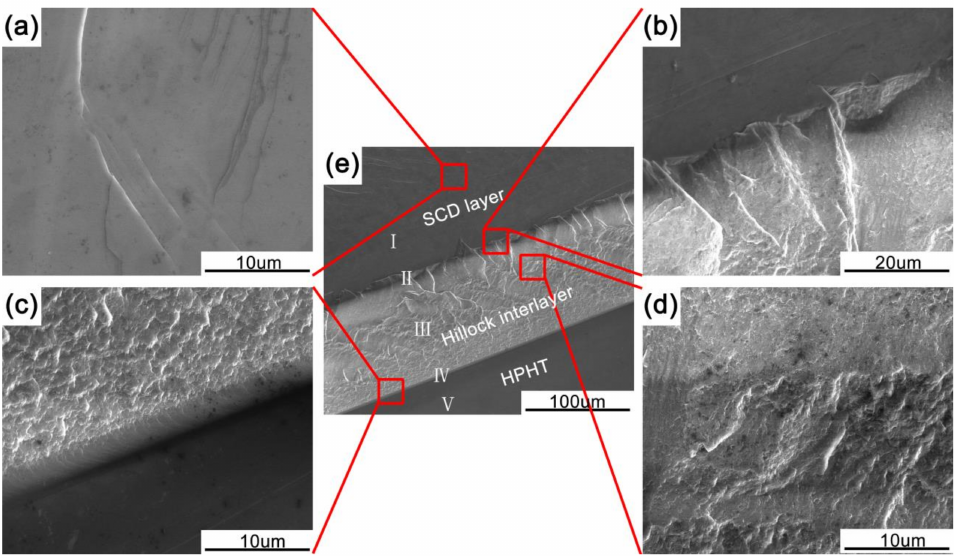
Figure 2. Cross-section SEM images of SCD layer/hillock interlayer/HPHT diamond structure. ( a ) Magnified SEM image of SCD layer; ( b ) magnified SEM image of the interface between the hillock interlayer and SCD layer; ( c ) magnified SEM image of transition region between the HPHT and hillock interlayer after the hillock growth; ( d ) magnified SEM image of hillock interlayer; ( e ) and cross-section SEM image of the homoepitaxial grown diamond, wherein the location with Roman numeral marker indicated the measure position of Raman and